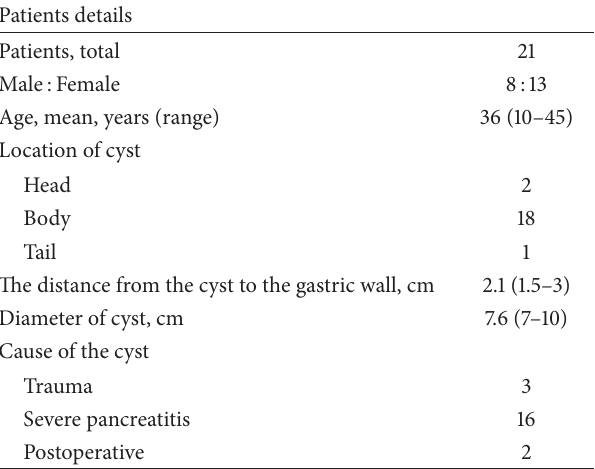
Table 1: Patient characteristics in this study.